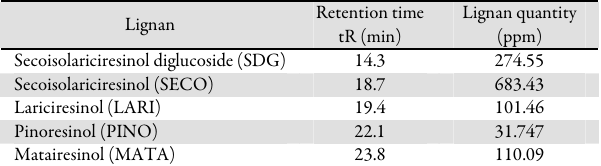
Retention time Lignan quantity tR (min) (ppm)